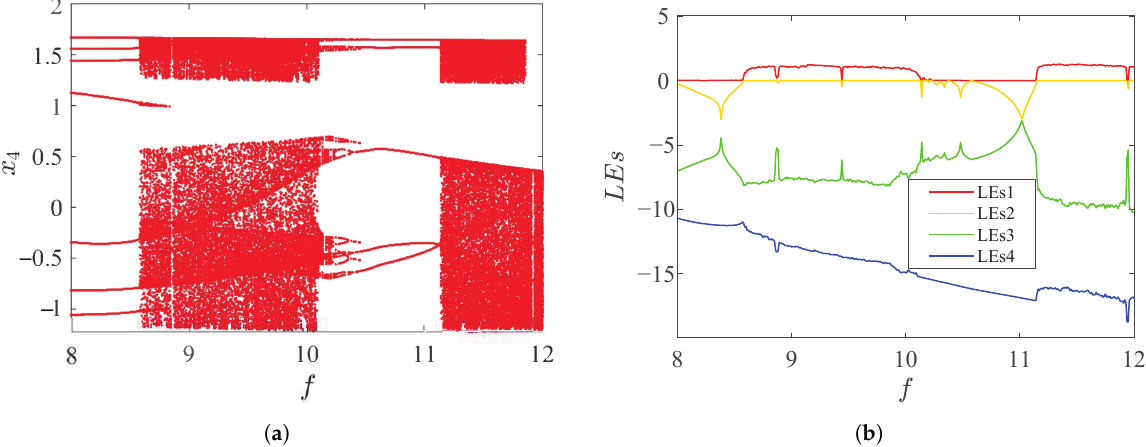
Figure 9. Dynamical behaviors with different parameter f of system (15). ( a ) Bifurcation diagram; ( b ) LEs.